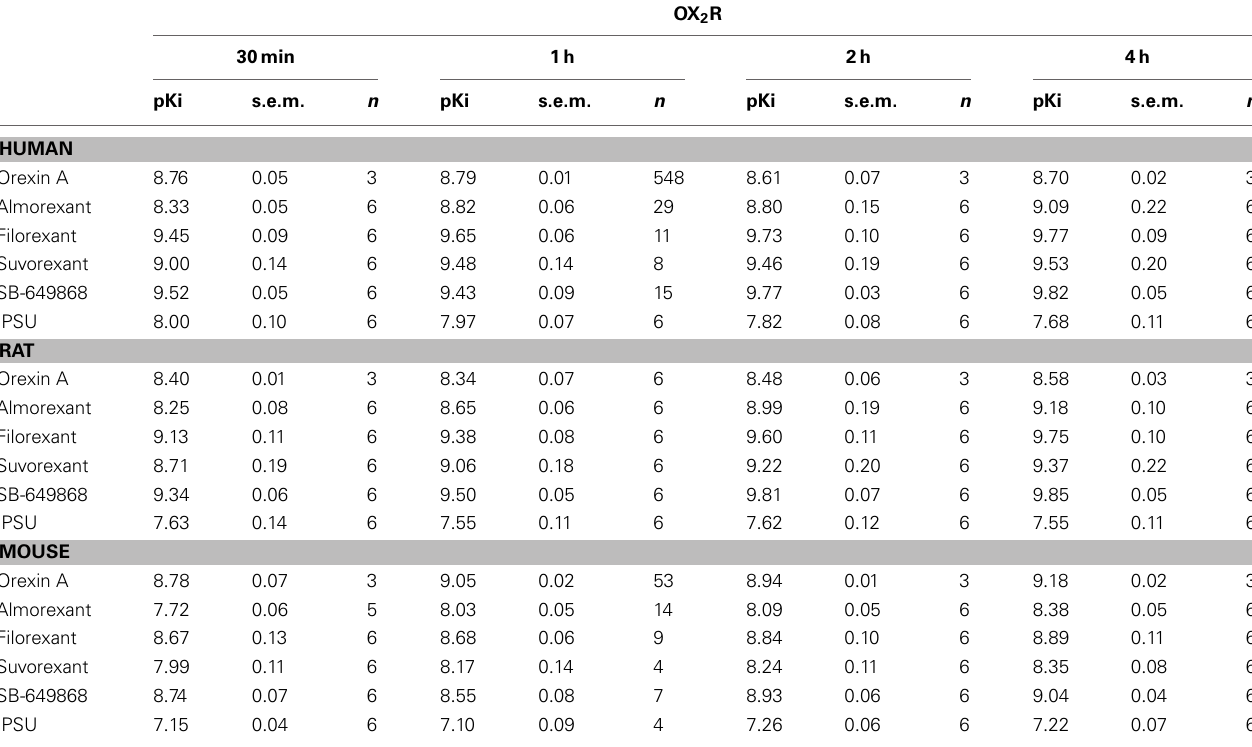
Table 2 | Ca 2 + signaling in cells stably transfected with human (CHO), rat (HEK) or mouse (HEK) OX 2 R in the presence of the endogenous agonist (orexin A) or putative dual orexin receptor antagonists (almorexant, filorexant, suvorexant, SB-649868, and